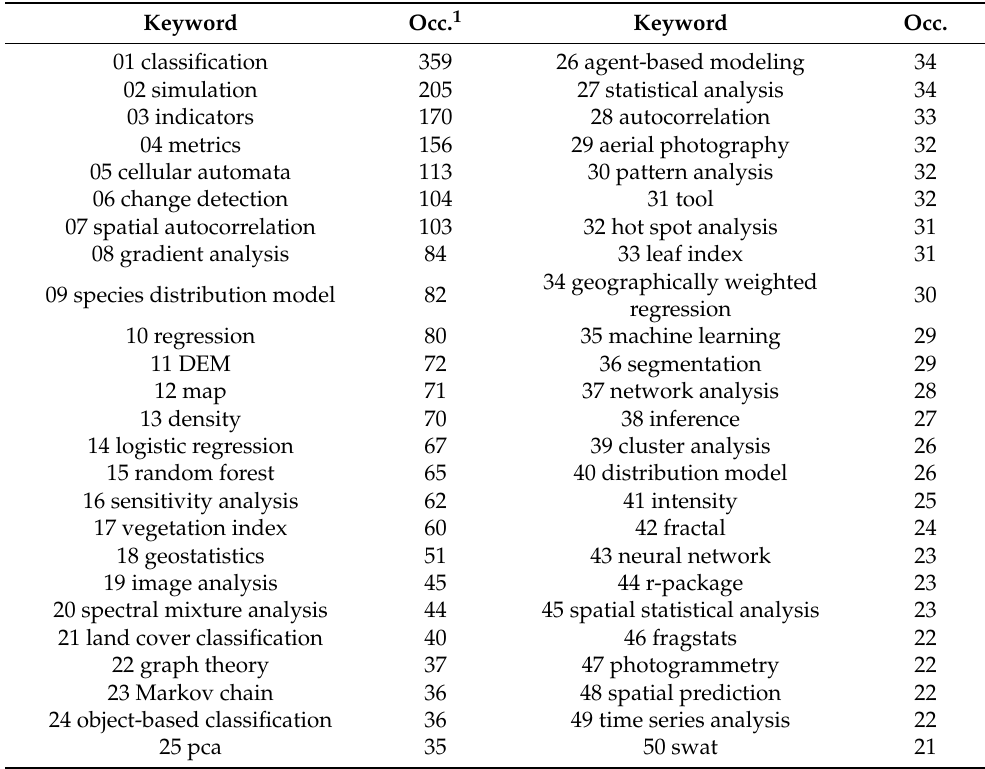
Table 1. First 100 keywords with the highest number of